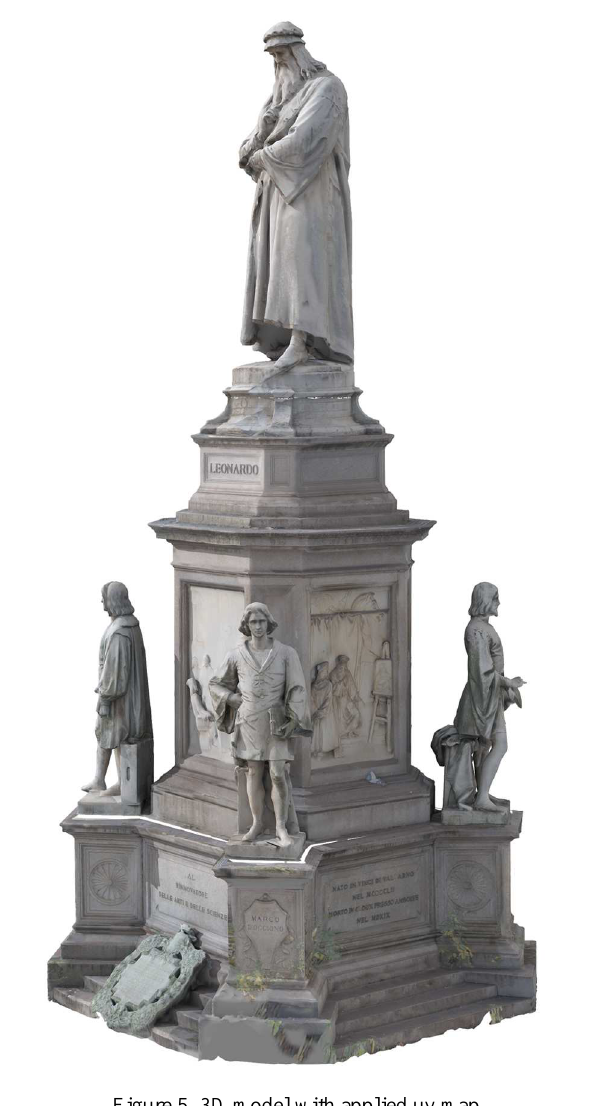
Figure 5. 3D model with applied uv